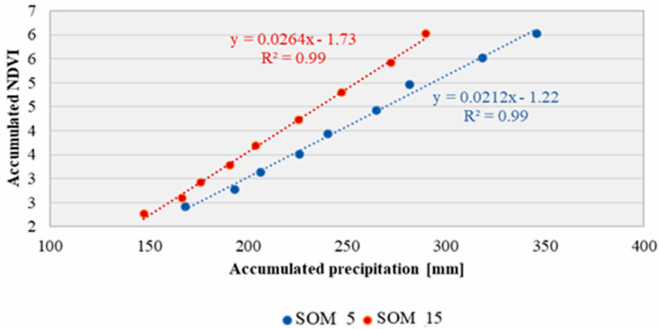
Figure 6. Linear correlation between accumulated values of precipitation and NDVI patterns from January (DOY 01) to May (DOY 145).